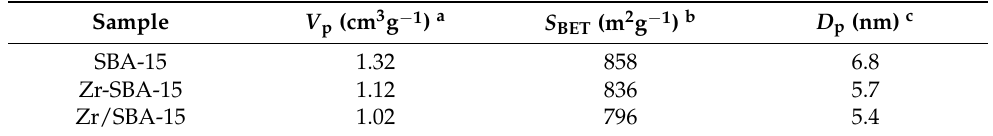
Table 2. Physical properties of SBA-15, Zr-SBA-15, and Zr/SBA-15 catalysts.